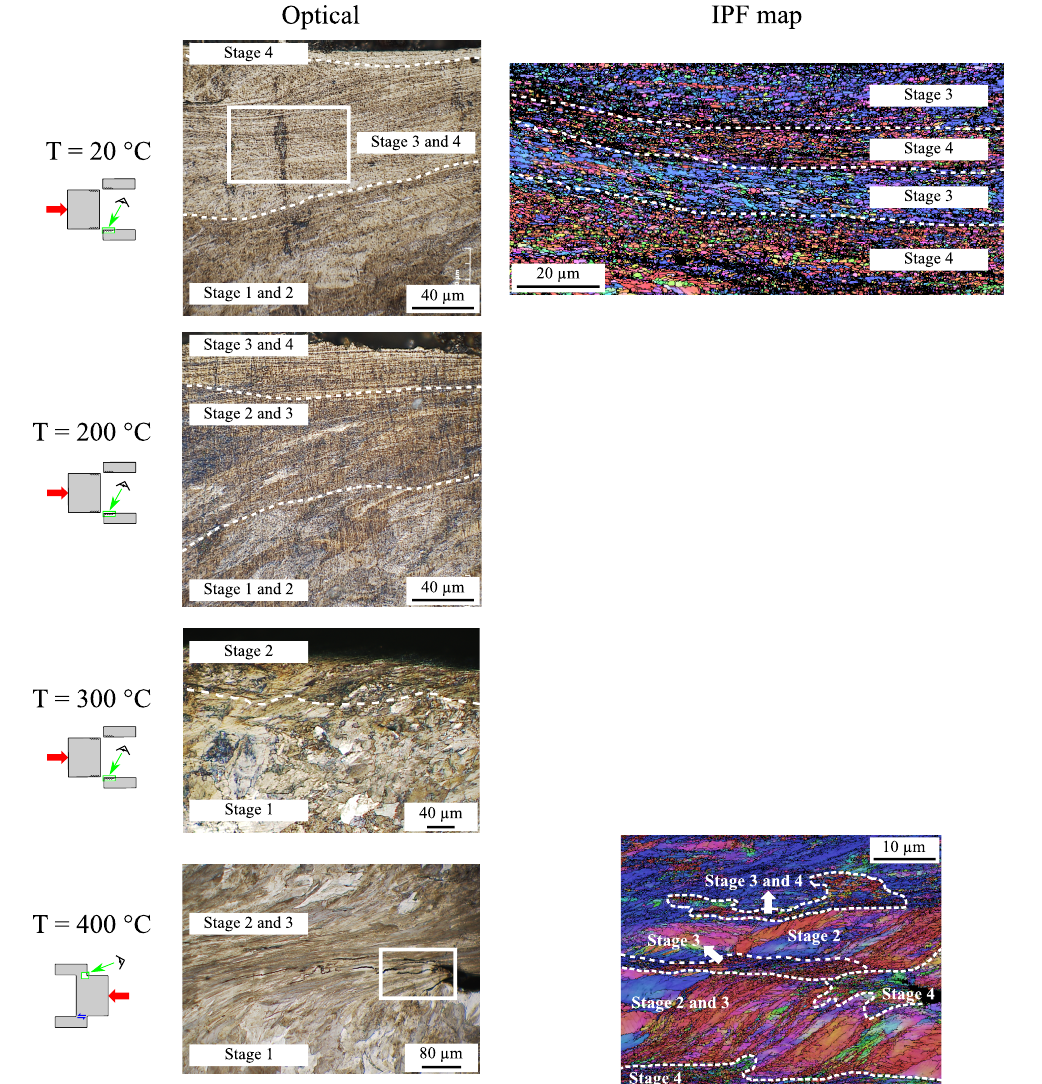
Figure 9. Effect of temperature on the microstructural gradient in the sheared zone of the specimen at the end of the monotonic tests. The specimen failed at the tests performed at T = 20 ◦ C, 200 ◦ C, and 300 ◦ C but did not fail at 400 ◦ C. IPF maps were constructed for the tests performed at room temperature (step size = 0.08 µ m) and 400 ◦ C (step size = 0.1 µ